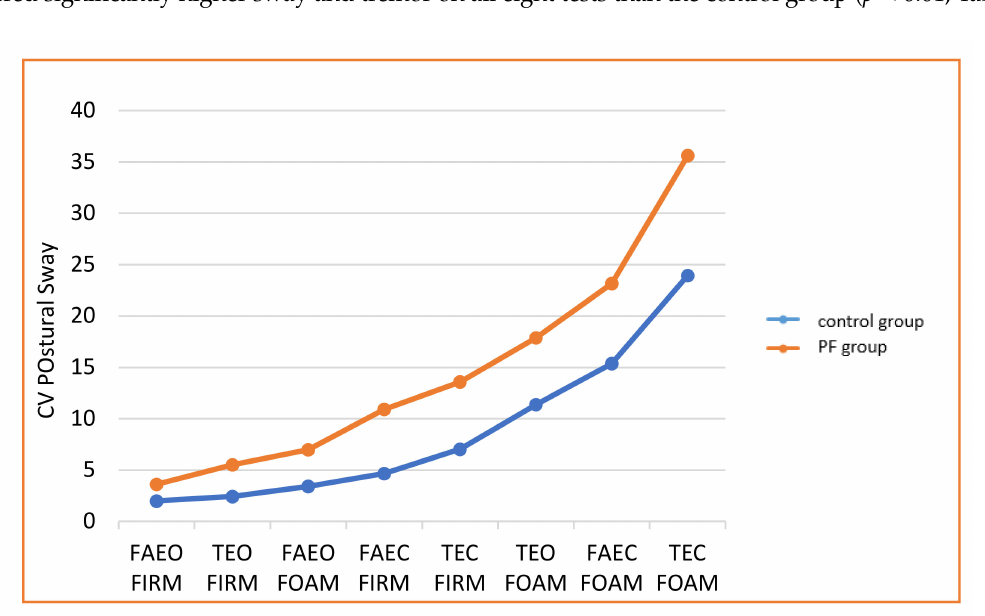
Figure 1. The postural sway in the eight balance task challenges used here by increasing order of di ffi